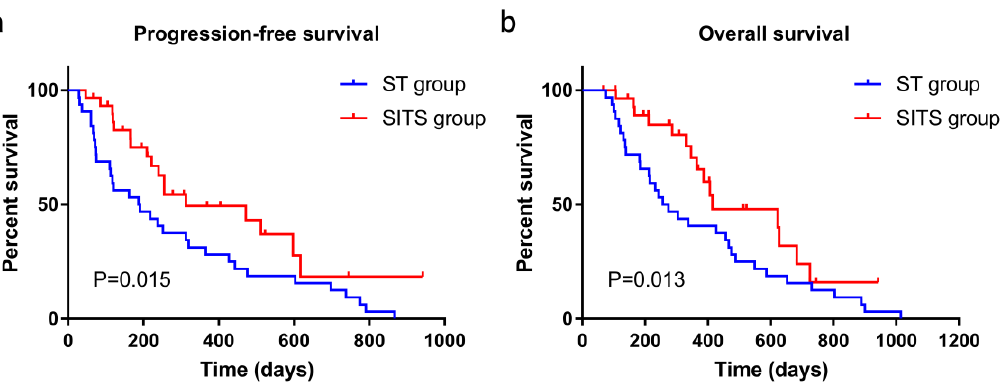
Figure 2. Kaplan–Meier curve analysis of PFS ( a ) and OS ( b ) in both patient groups. PFS, progression-free survival; OS, overall survival.